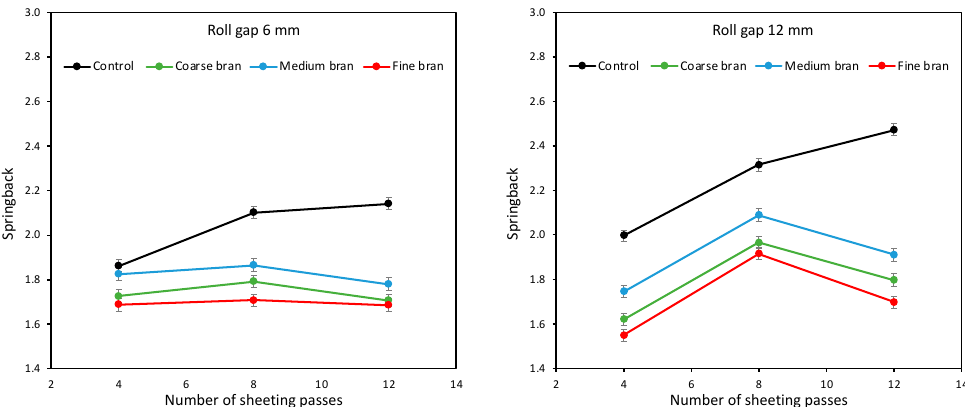
Figure 8. Average springback of doughs containing 10% of Coarse, Medium and Fine bran, sheeted at roll gaps of 6 mm ( left ) and 12 mm ( right ) for 4, 8 and 12 sheeting passes.